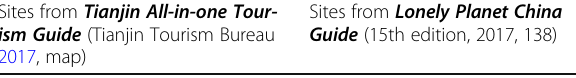
Table 1 Table comparing the sites appearing on two maps of Tianjin published in 2017 (sites common to both are in boldface) (Continued) Sites from Tianjin All-in-one Tour- ism Guide (Tianjin Tourism Bureau 2017,